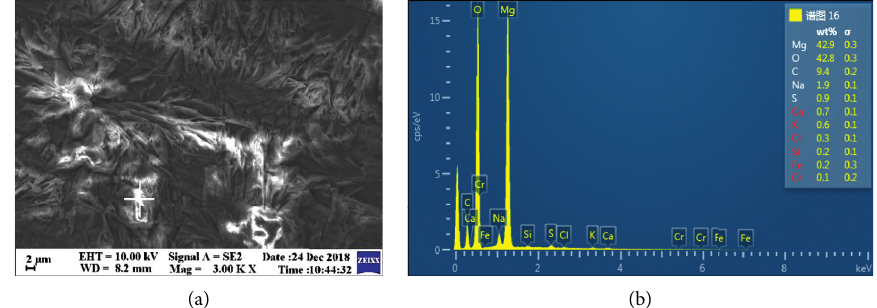
Figure 14: Superficial morphology experiment and EDS analysis of the directly heated magnesium alloy plate by SEM (3000 times) without cathodic protection voltage.